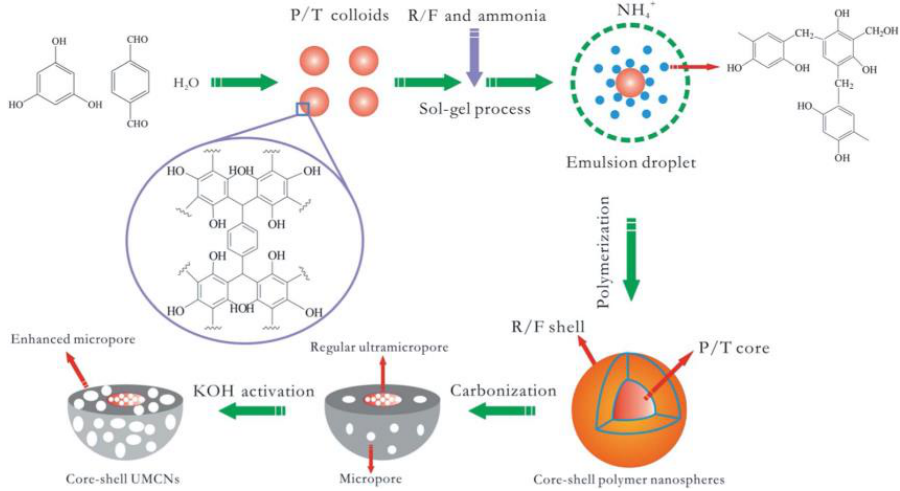
Figure 36. Schematic synthesis of 3D core–shell UMCNs with regular ultra-micropores in the cores and abundant micropores in the shells (reproduced from the work in [79] with permission). The rectangular shaped cyclic voltammogram (CV) of electrode sample UMCN-60 displays fast ion-transport and good capacitive performance for quick charge–discharge operation as seen in Figure